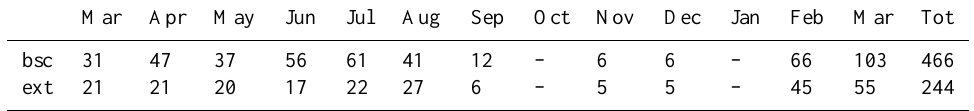
Table 1. The amount of one-hour backscatter and extinction profiles for each month from March 2008 to March 2009.